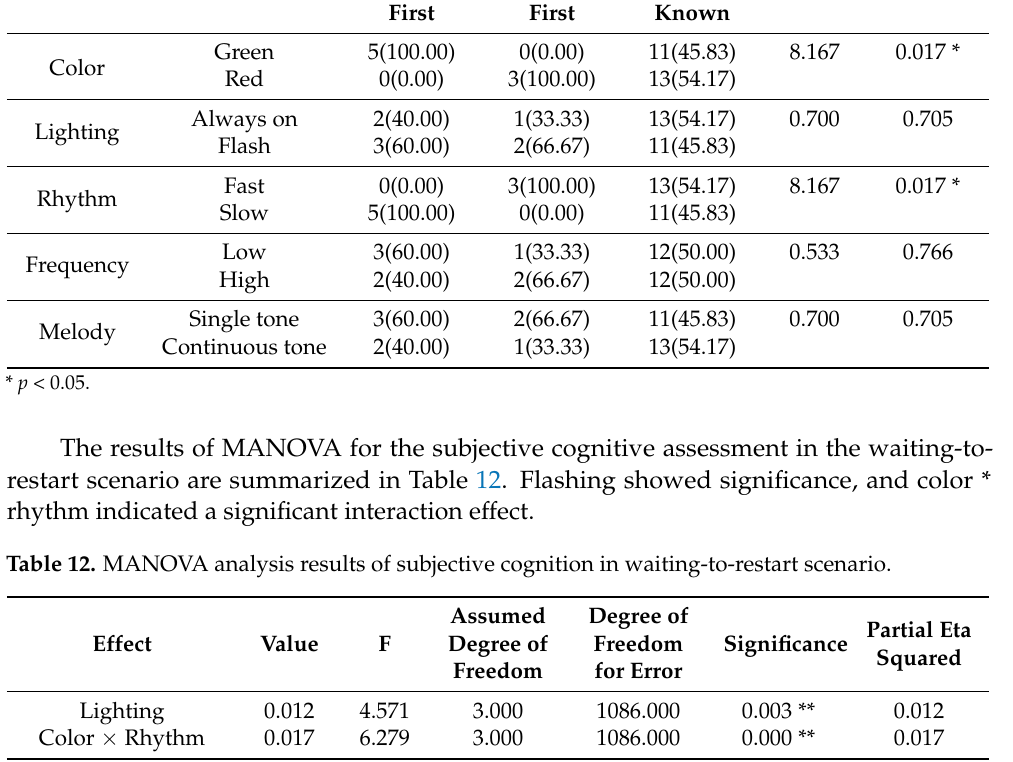
χ 2 p Road-User